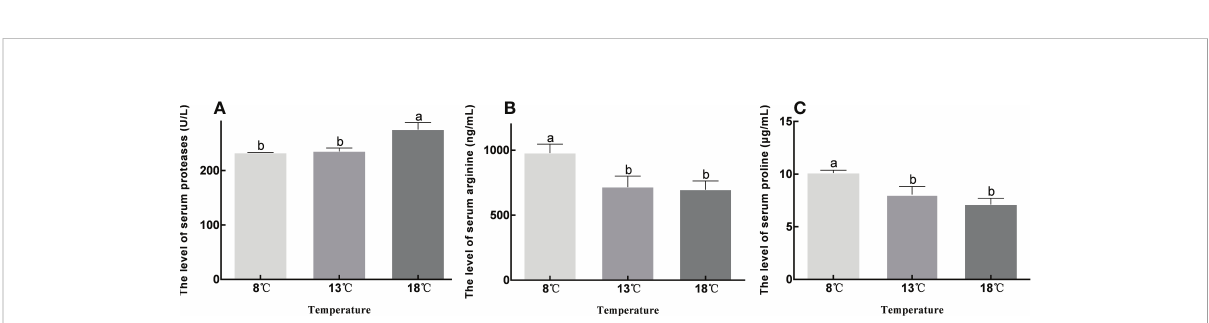
FIGURE 7 Contents of proteases, arginine and proline in serum at different temperature groups. Data were presented as the mean ± SEM. Different letters indicate signi fi cant differences between groups ( P